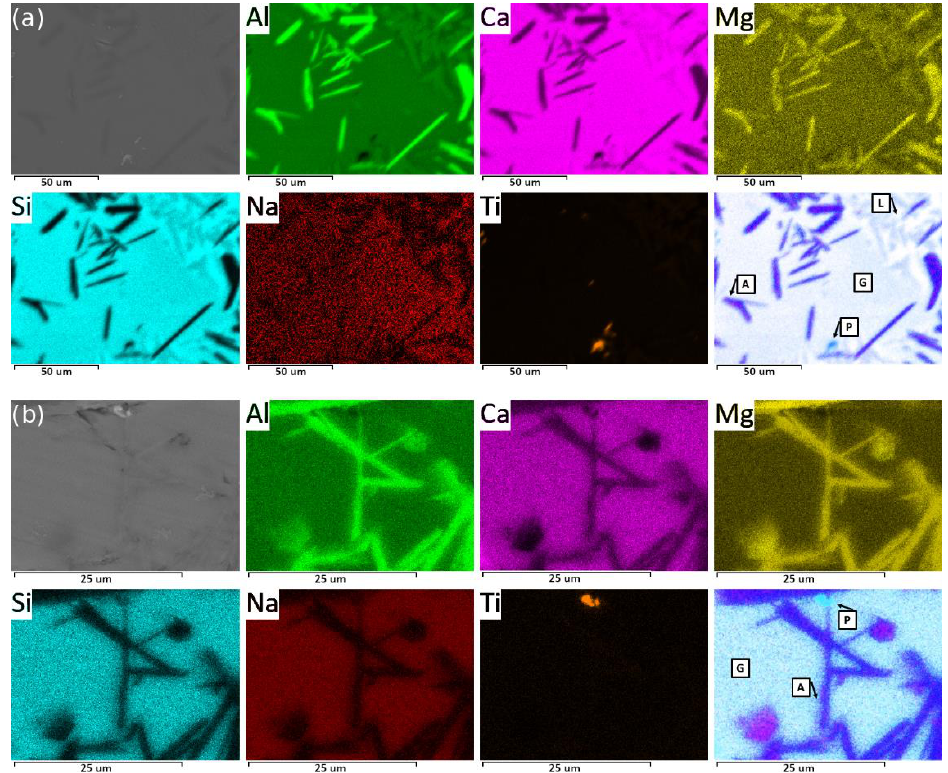
Figure 9. Compositional map for the slag obtained after reduction at 1500 °C: ( a ) sample C2 and ( b ) sample A2.